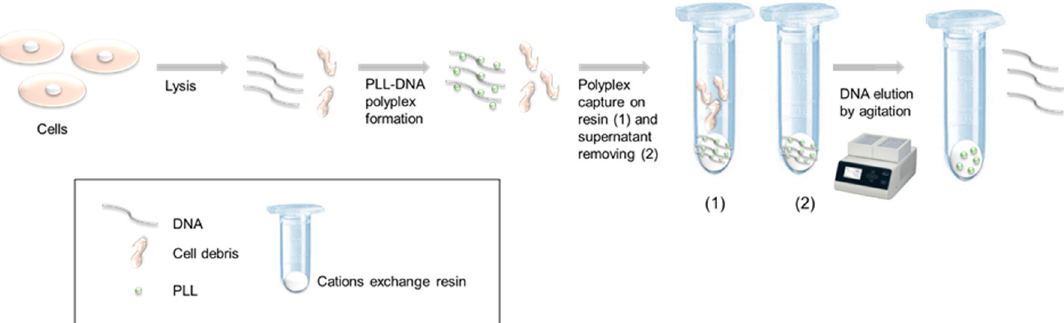
Figure 1. Principe of DNA extraction and purification while using DNA-polylysine (PLL) resin complex. (1) polyplex was captured on resin (2) supernatant was removed.